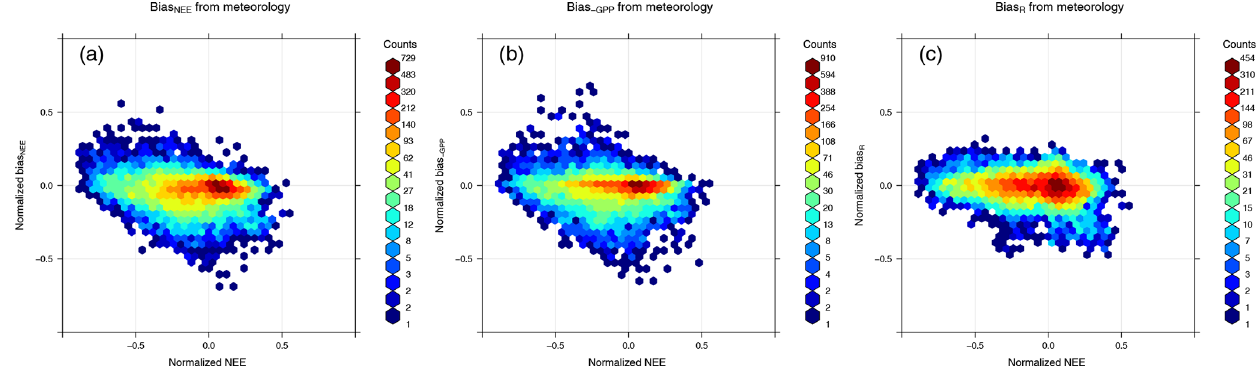
Figure 3. (a) Distribution of normalized Bias NEE due to meteorological error. The x axis refers to the normalized NEE, and the y axis refers to the corresponding Bias NEE defined in Sect. 2.2. Panels (b) and (c) share the same x axis with (a) but have Bias − GPP and Bias R in y axis instead. The three biases combine as Bias NEE = Bias − GPP + Bias R , suggesting larger contribution from photosynthetic part Bias − GPP , which is controlled by the radiation parameter rather than temperature.